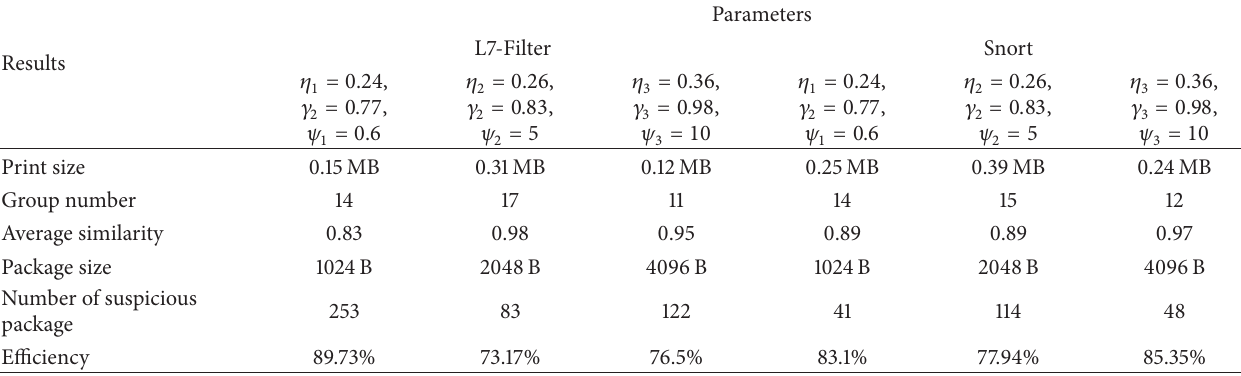
Table 2: Experimental data.